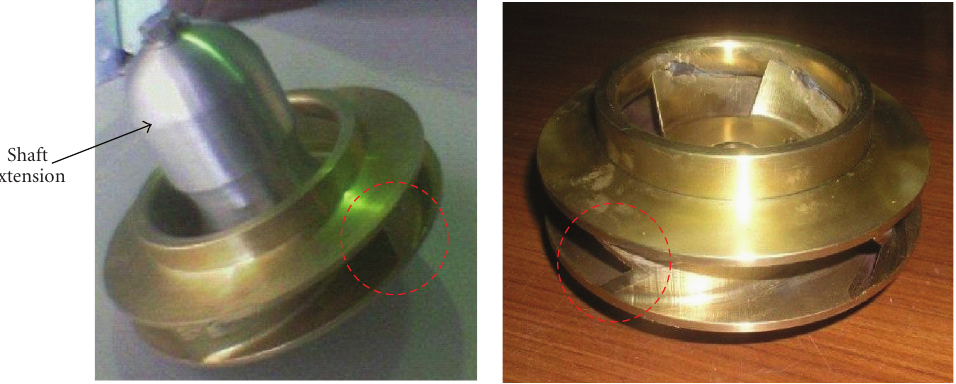
Figure 2: Model impellers.